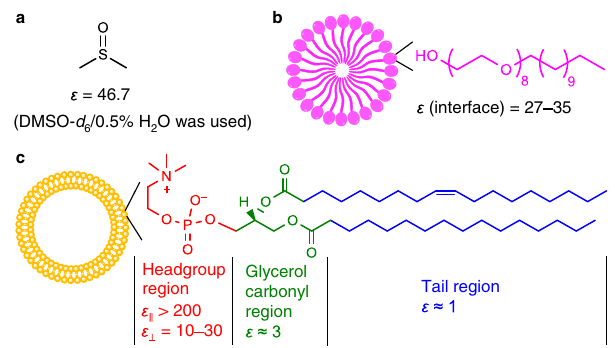
Fig. 3 | Dielectric properties of three media used for anion binding studies in thispaper.a DMSO. b C12E8micelles,wheretheinterfacialdielectricconstantwas determined by Drummond et al. 24 based on p K a shifts of lipoidal pH indicators. c POPC vesicles with theoretically modelled dielectric constants. The dielectric constants of the headgroupregion weretakenfrom Stern& Feller 28 and Raudino & Mauzerall 29 , and the values of the remaining regions from Nymeyer & Zhou 27